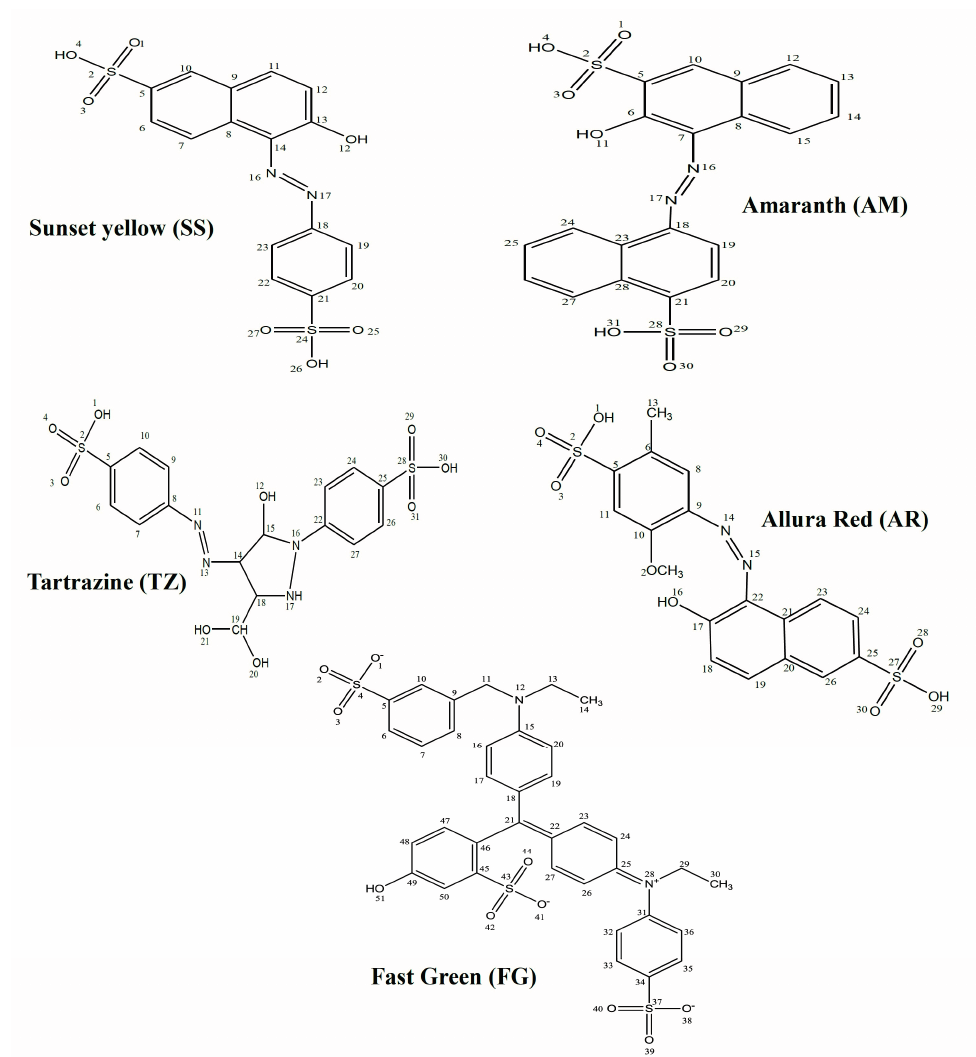
Figure 1. Molecular structures of the studied